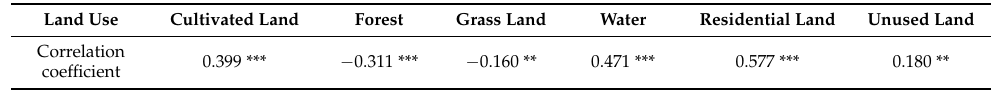
Table 1. Correlation analysis between population and land-use type (by area). Land Use Cultivated Land